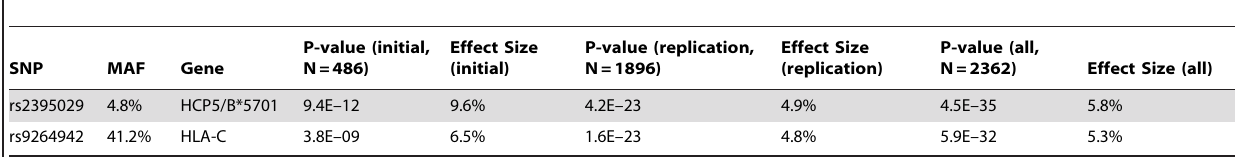
Table 1. P-values and population effect sizes (or explained fraction of the inter-individual variability) for the strongest determinants of HIV-1 viremia at set